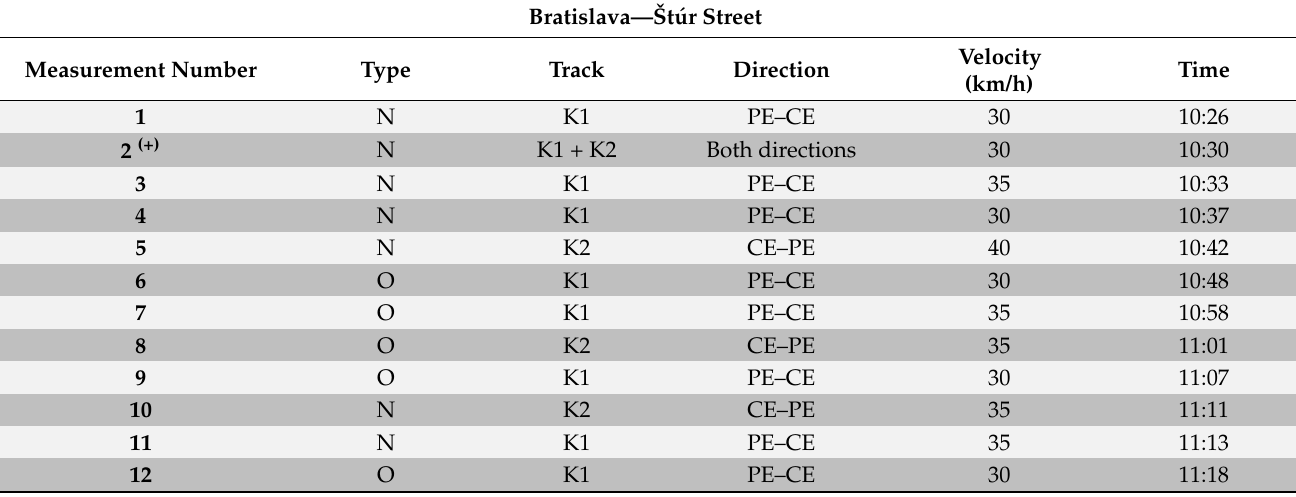
Table 1. Overview of experimental measurement data in Bratislava, Št ú r